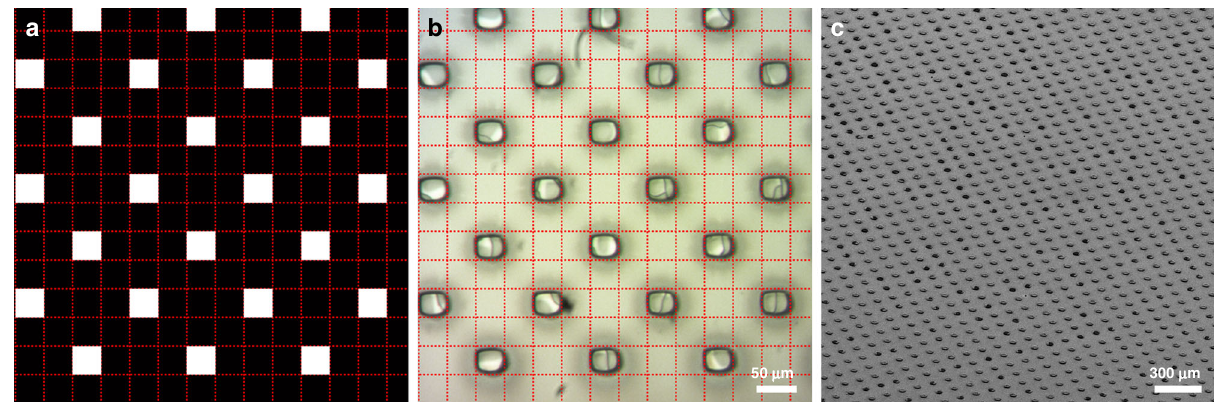
Fig. 2 High-resolution printing. Projection pattern ( a ) and optical microscopy image ( b ) of a print at single pixel resolution (red dotted lines outline the mirrors of the DMD). c SEM image of a print at single pixel resolution.